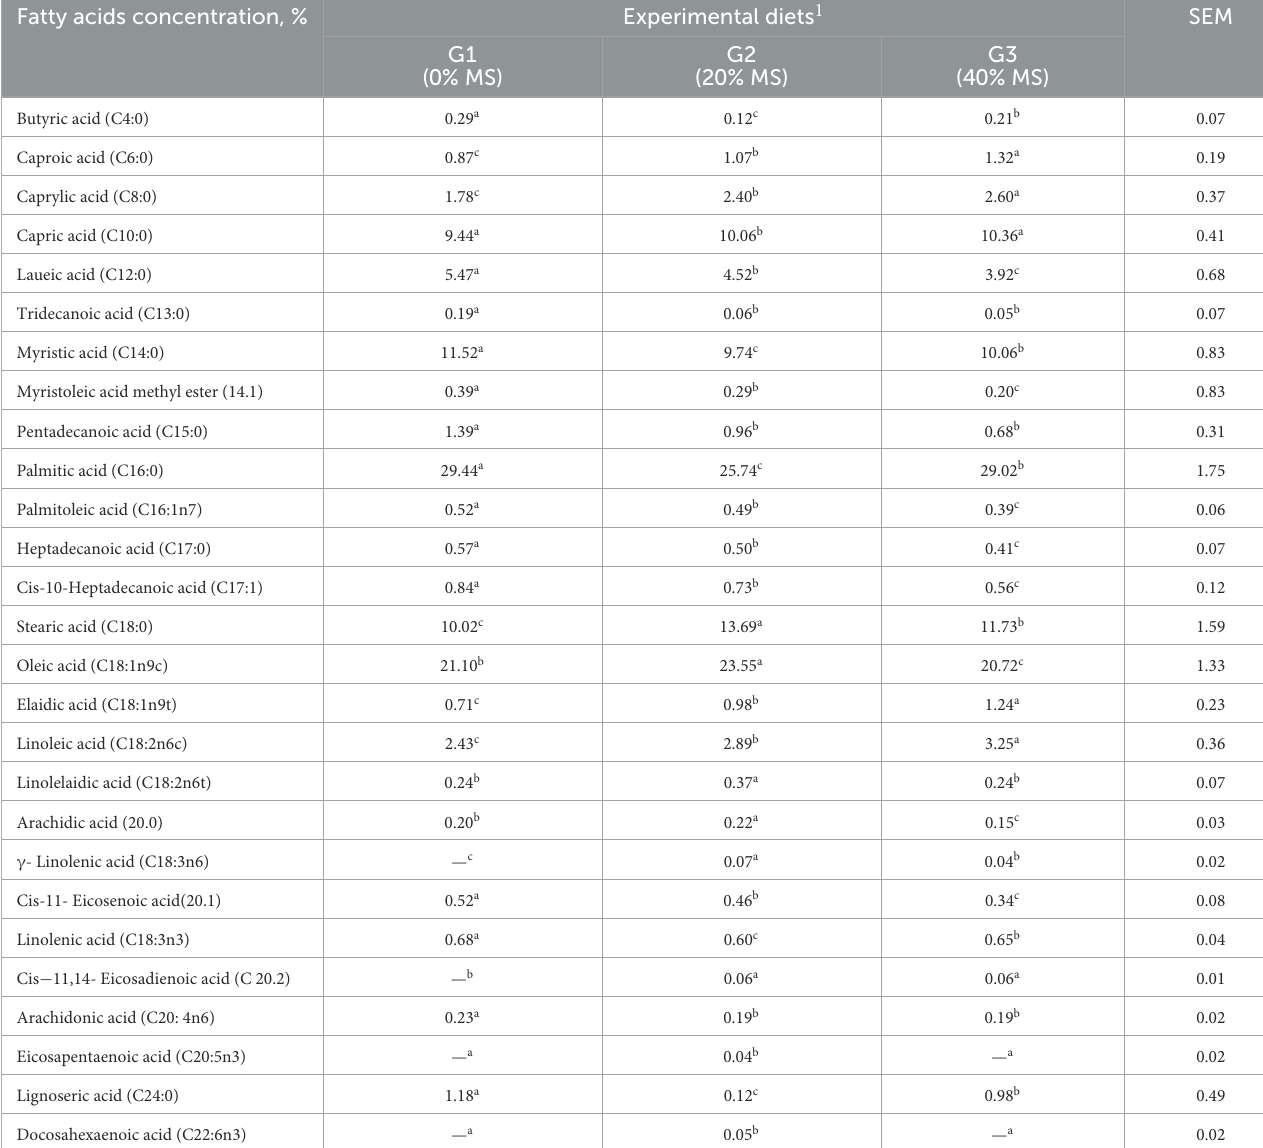
TABLE 9 Milk fatty acid profile in dairy goats fed MS replacing corn. Fatty acids concentration, % Experimental diets 1 SEM